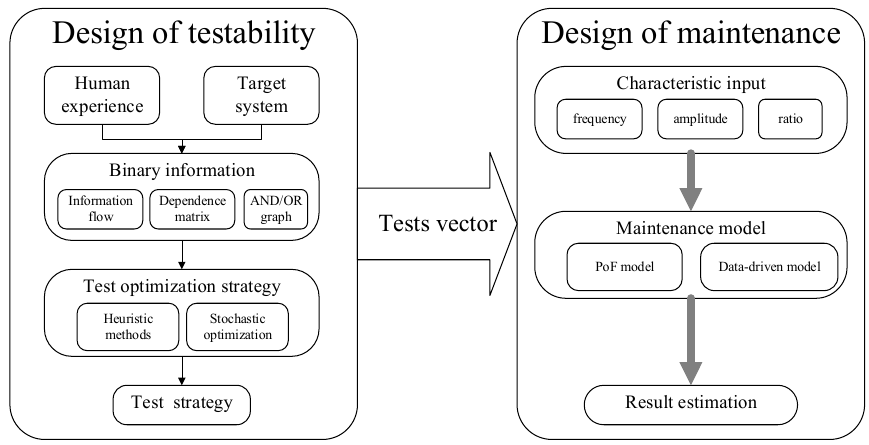
Figure 2. Traditional framework of testability and maintenance design.